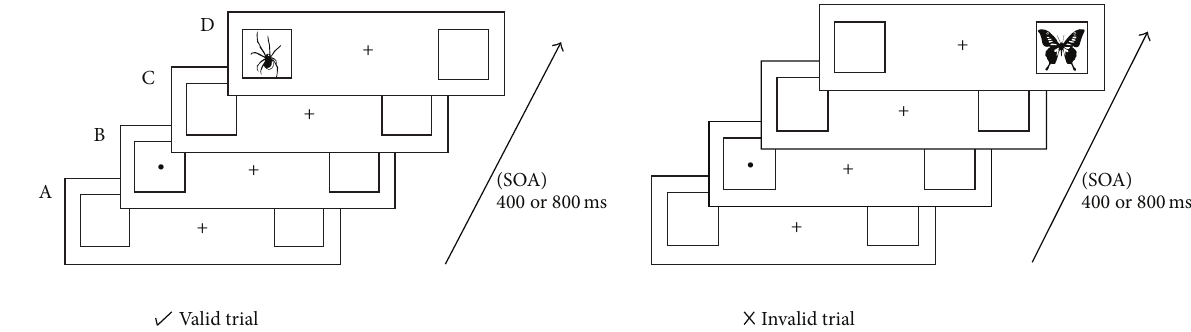
Figure 2: Sequence of events in a valid and invalid trial: (A) two empty frames appeared on the left and right of the fixation cross; (B) cue was presented for 200 ms in one of the frames; (C) two empty frames appeared again for 400 ms or 800ms; (D) target stimulus was presented in the cued or uncued